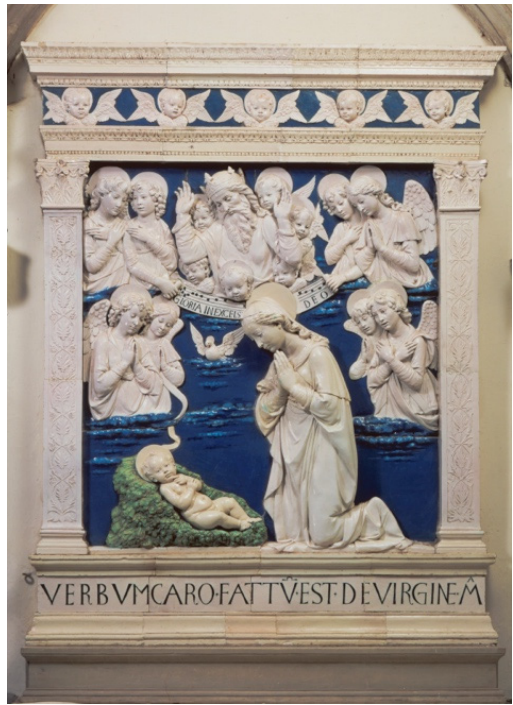
Figure 6. Andrea della Robbia, Adoration , enamel terra cotta, Chiesa Maggiore, La Verna (photo source: Scala/Art Resource, NY).